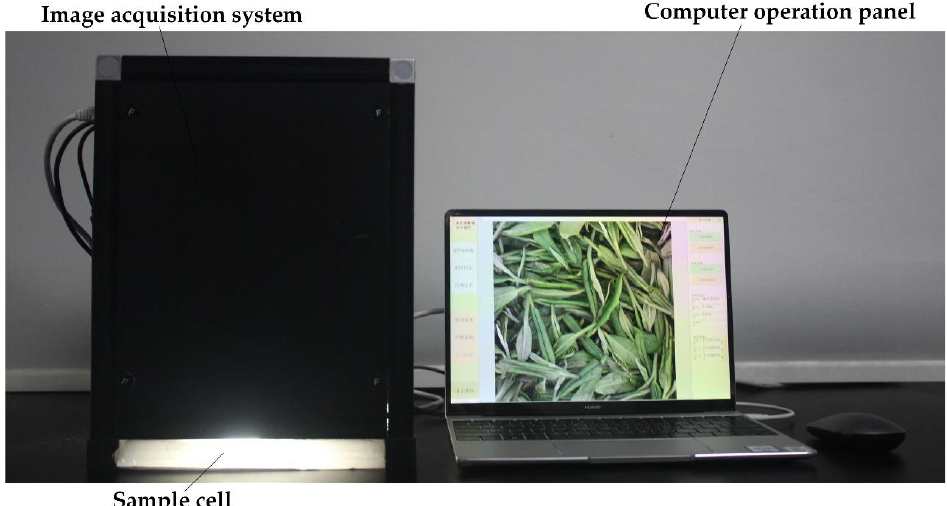
Figure 3. Image acquisition process. For image acquisition, the sample is placed in the sample cell with an industrial camera at the top and the image is acquired on a computer operating system.